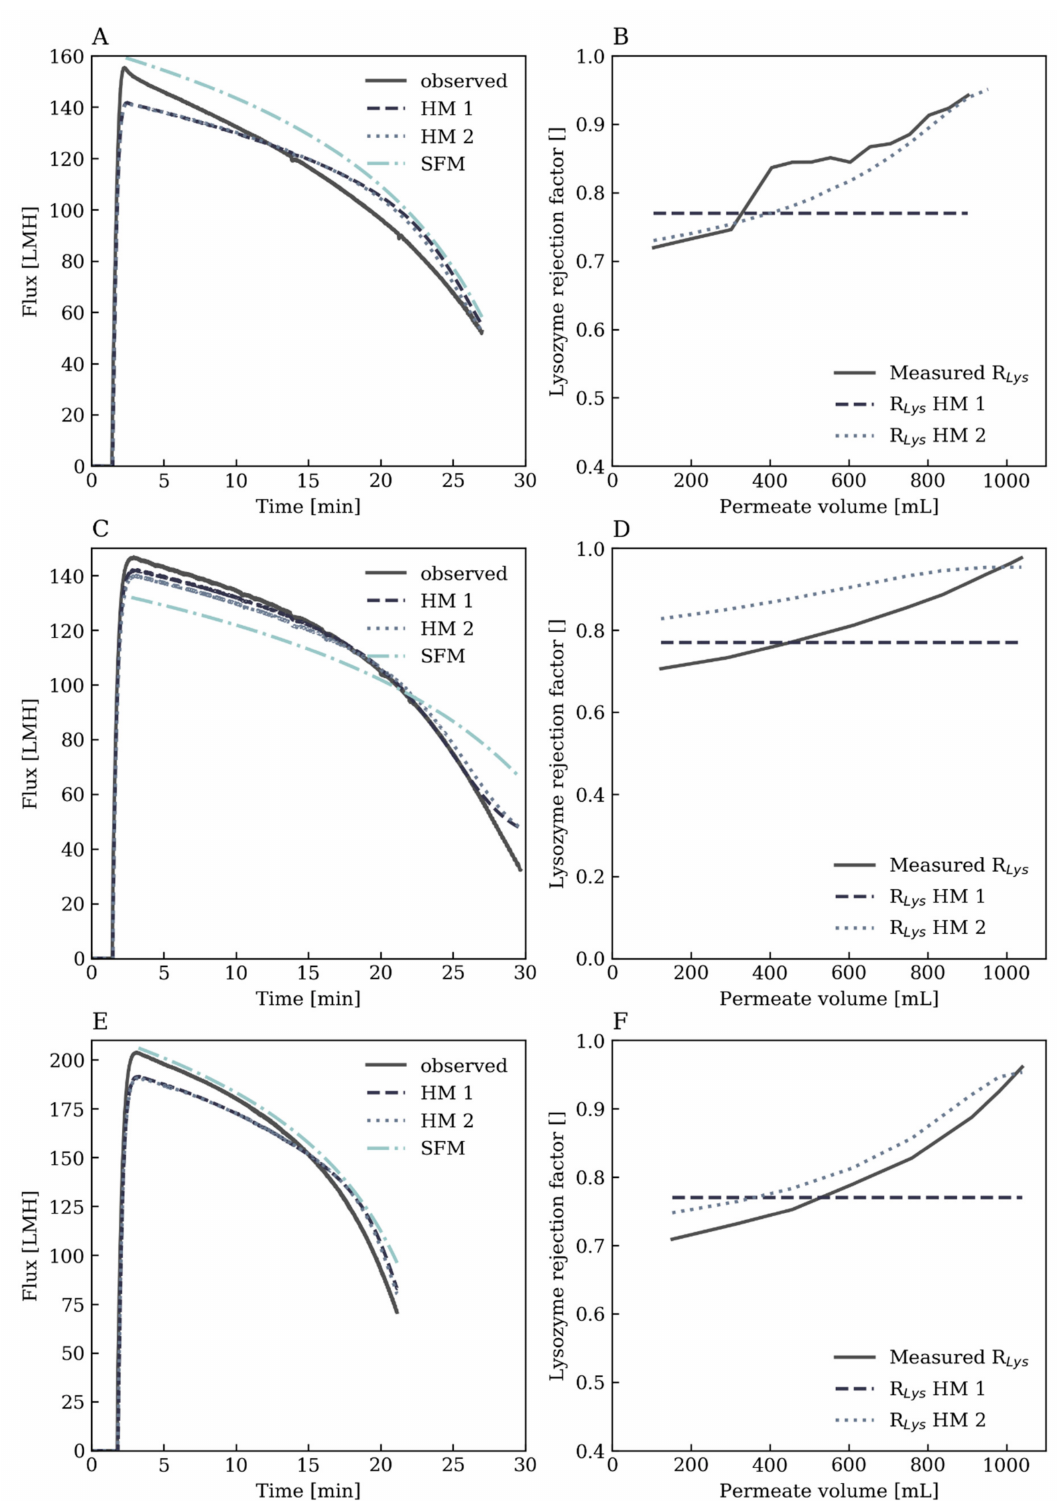
Figure 7. Comparison of observed and predicted flux and R Lys . ( A ) The flux over time of test run 2, ( B ) R Lys over permeate volume of test run 2, ( C ) the flux over time of test run 6, ( D ) R Lys over permeate volume of test run 6, ( E ) the flux over time of test run 7, ( F ) R Lys over permeate volume of test run